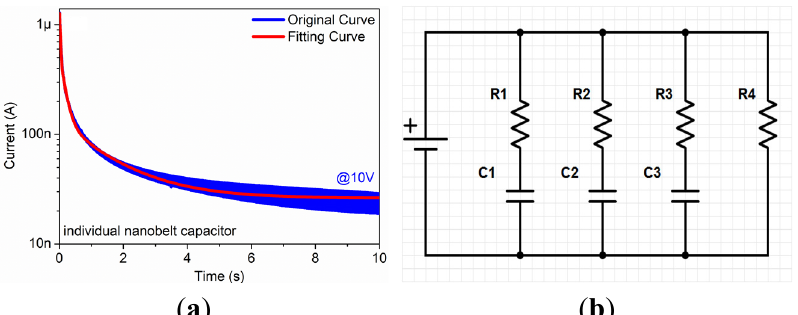
Figure 4. ( a ) I/V-t sweep measurement of the individual Ga 2 O 3 nanobelt on Pt IDEs, and ( b ) simplified impedance model of the individual Ga 2 O 3 nanobelt on Pt IDEs.